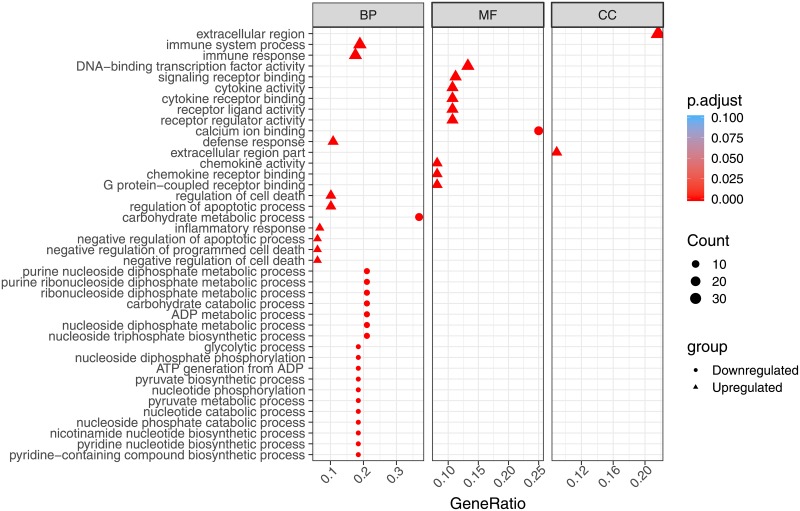
Gene ontology enrichment analysis of the differentially expressed genes from vaccinated fish comparing to control fish.GO annotation based on Salmo salar OrgDb object. BP—Biological Processes, MF—Molecular Function and CC—Cellular Components. Color gradient from red to blue, where red indicates high enrichment (low p.adjust) and blue indicates low enrichment (high p.adjust). Dot size corresponds to count (number of DEGs in each term).